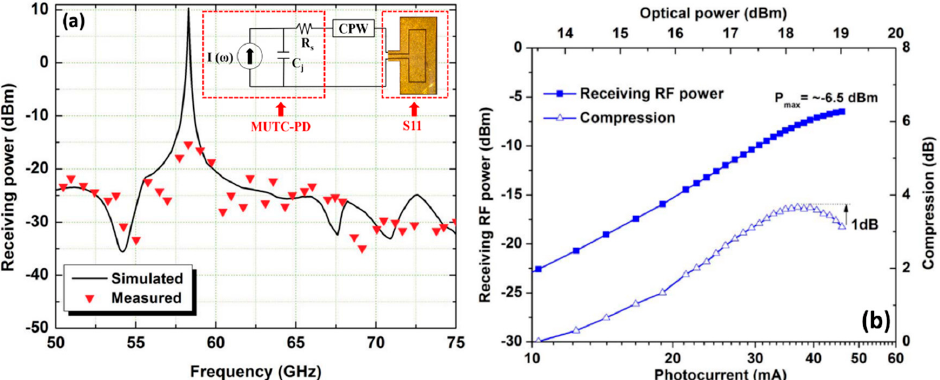
fiber amplifier, Att.: optical attenuator. amplifier, Att.: optical attenuator.